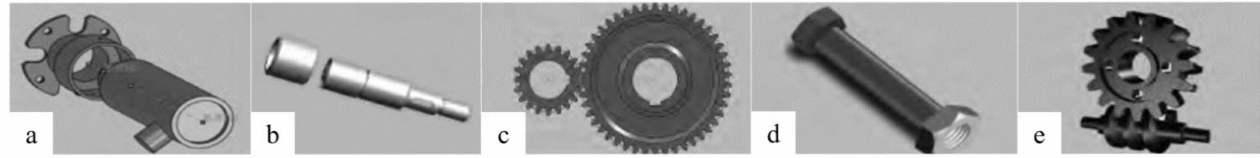
Figure 3. The types of typical assembly tasks: ( a ) matching, ( b ) conjugating, ( c ) joining, ( d ) fastening, and ( e ) meshing.